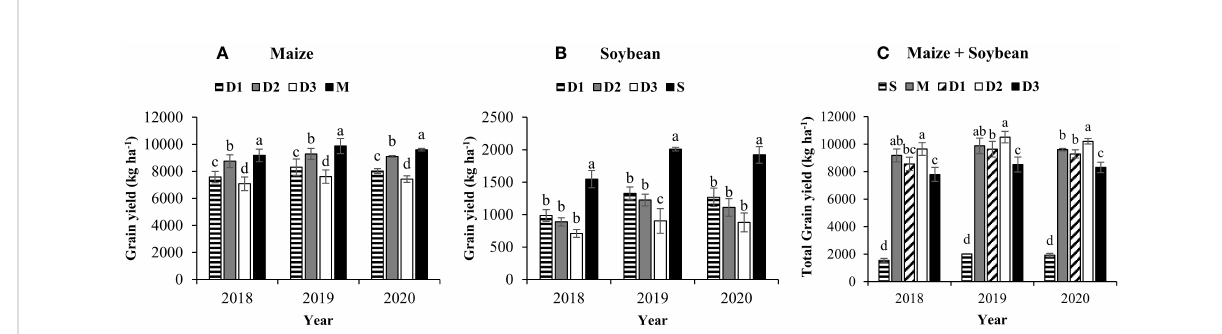
FIGURE 5 Three years average grain yield of maize (A) , soybean (B) , total grain yield (C) in response to different maize planting densities (6 maize plants m -2 , low, D 1 ; 8 maize plants m -2 , medium, D 2 ; and 10 maize plants m -2 , high, D 3 ) under maize/soybean strip intercropping. Bars show ± standard errors (n = 3). The different lowercase letters within a bar show a signi fi cant difference (p < 0.05) among treatments. The M and S represent the sole maize and soybean,